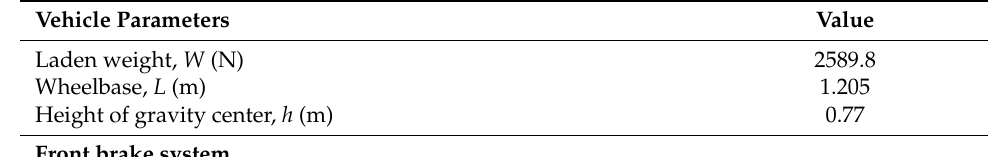
Table 1. Parameters for simulations.